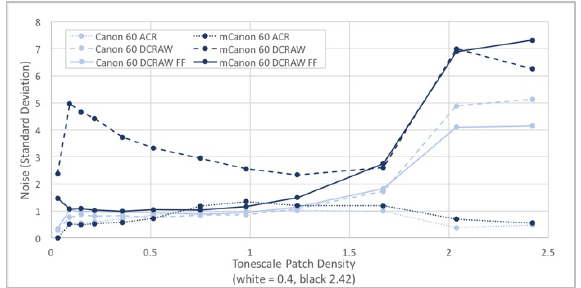
Figure 7. Visual noise measured from the grey patches of the DICE target. The figure plots the standard deviation of the digital values against the density of the tone scale patches from white to black. The figure compares the unmodified (‘Canon’) and modified (‘mCanon’) cameras using the Canon 50mm (‘50’) and the Coastal Optics 60mm (‘60’) lenses and image processing using ACR, DCRAW with scaling and gamma correction (‘DCRAW’), and DCRAW with flat field correction, scaling, gamma correction (‘DCRAW